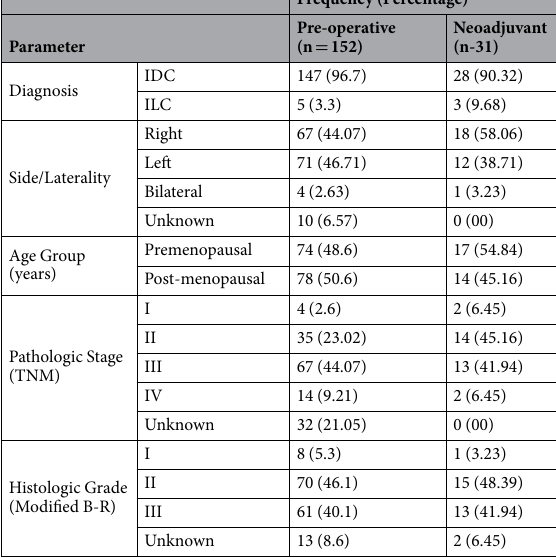
Table 1. Characteristics of Breast Cancer